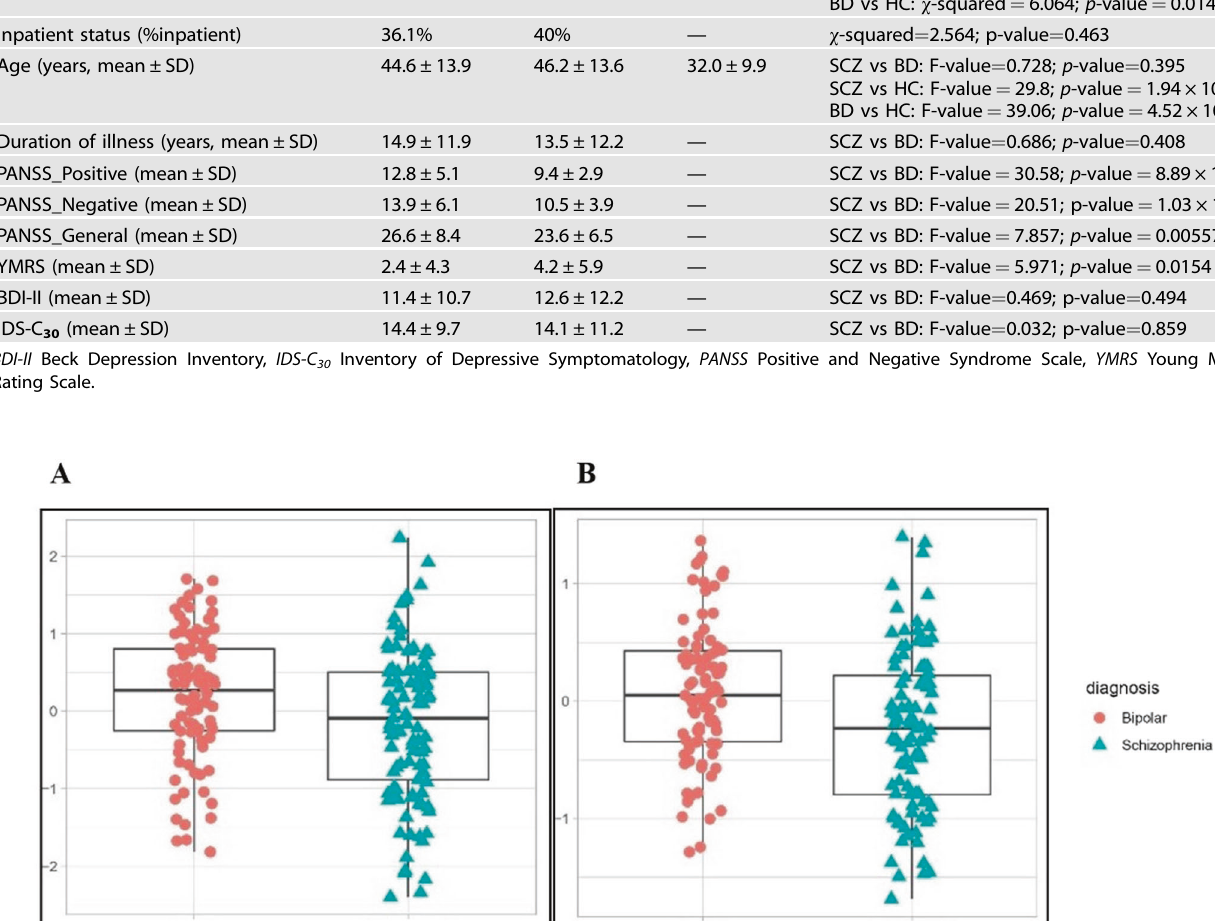
Model performance parameters were calculated with a 10-fold cross-validation scheme. When C9, IL1RAP, or proteome-based PC1 were used as predictors, alone or combined, and diagnostic status was used as the predicted variable, none of the predictors yielded an area under the receiver operating characteristic curve (AUC-ROC) above 69% (Supplementary Fig. S3, Supplementary Table S6). Regression analysis for effects of SCZ-PRS, BD-PRS, and SCZ-vs- BD – PRS on the levels of serum proteins revealed several nominal associations ( p < 0.05, uncorrected) with each of the PRS. However, after Bonferroni and FDR corrections, no association remained signi fi cant. Likewise, none of these PRSs had a detectable in fl uence on proteomic-derived PCs (Supplementary Tables S7-S12). Center of recruitment and season of the year when the samples were collected did not show signi fi cant effects in the omnibus tests after multiple testing correction (Supplementary Tables S13, S14), so they were not included as covariates in linear/logistic models. Sex had